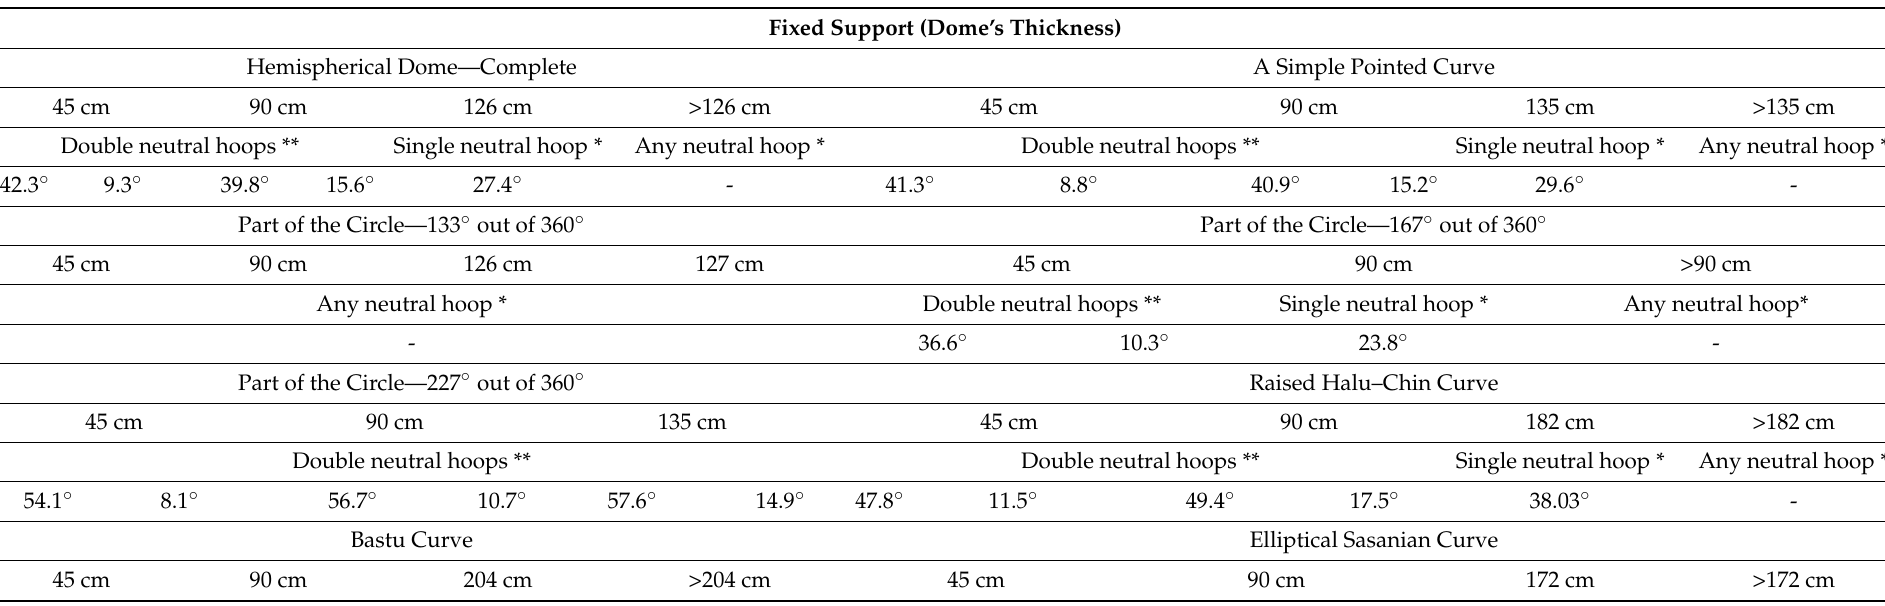
Table 5. Analysis of domes with fixed support and various thicknesses—R m = 5